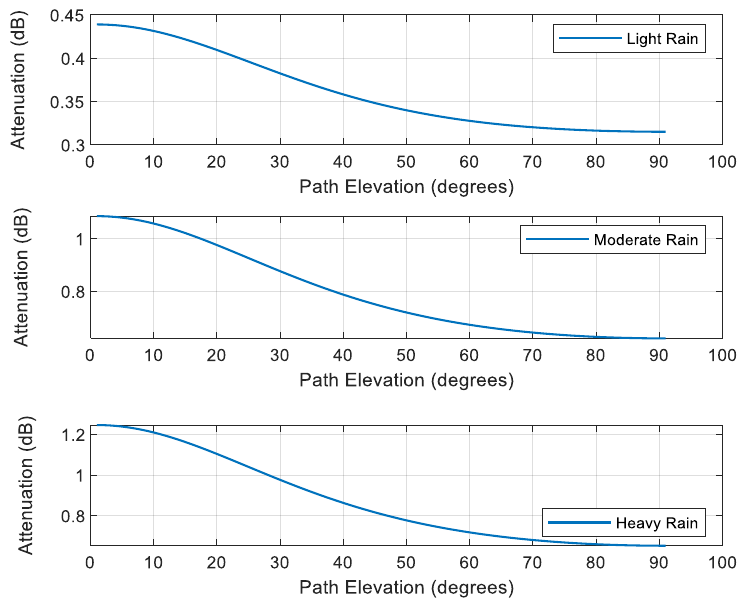
Figure 7. Rain attenuation plot versus elevation angle and rainfall depth levels.